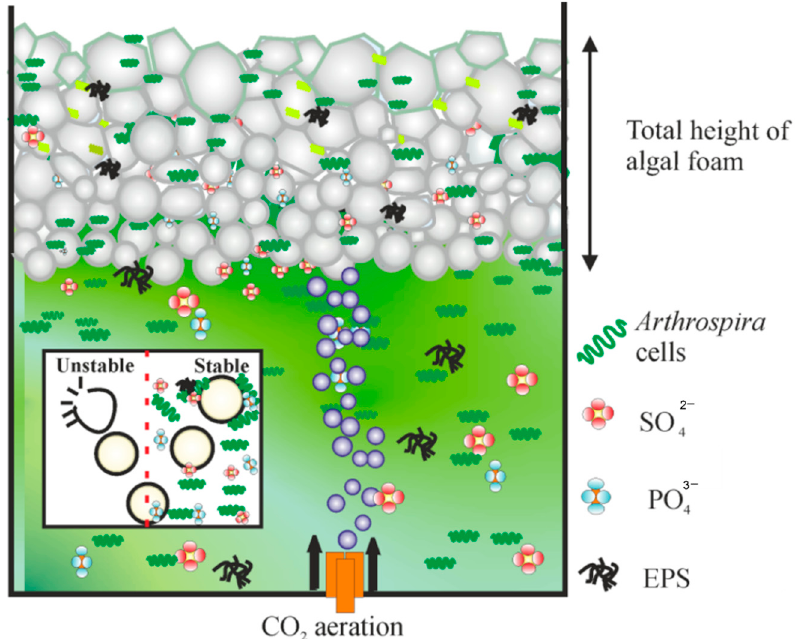
Figure 3. Mechanism of foam formation during cultivation of A. platensis .